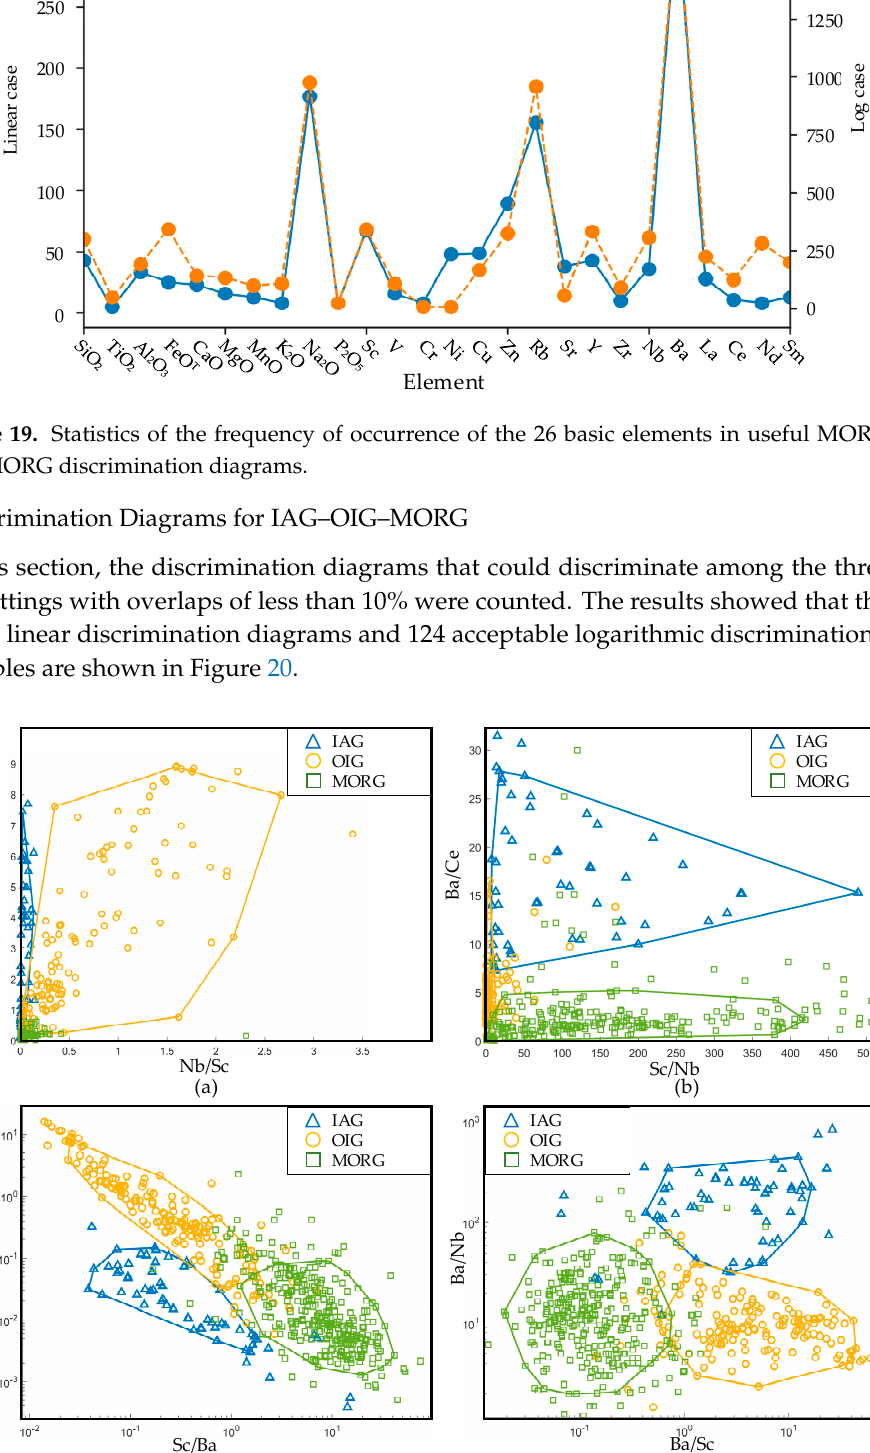
(a) (b) Figure 21. Word clouds of the top 20 important elements (or element ratios) for IAG–OIG–MORG discrimination diagrams. ( a ) is for linear coordinates; ( b ) is for logarithmic coordinates.